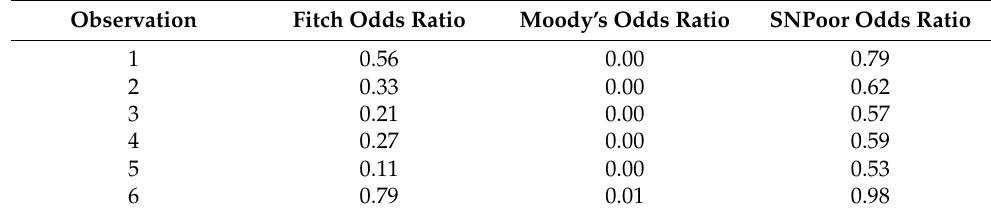
Table 9. Odds ratio of observations not used in the